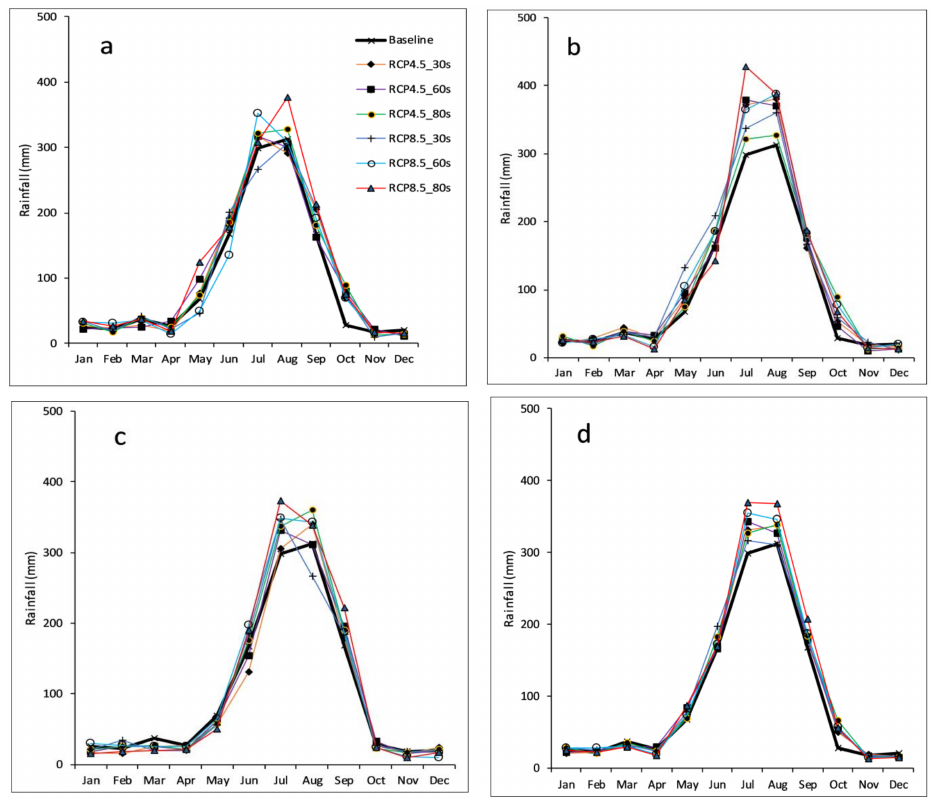
Figure 9. Comparison of monthly rainfall between observed (1975–2005) and projected climate in the three future periods. ( a ) BCC-CSM1.1; ( b ) CCSM4; ( c ) MIROC-ESM; and ( d ) Ensemble.